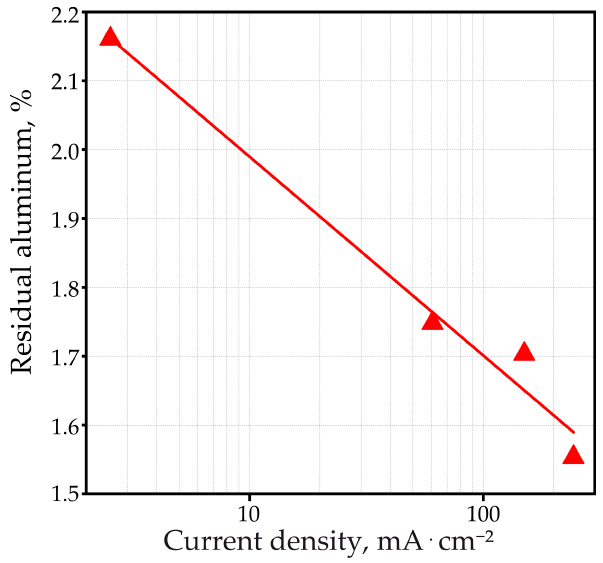
Figure 12. Quantification of residual aluminum content versus anodic current density based on areas under the 65.11° aluminum peak during galvanostatic anodizing in pure 0.6 M malonic acid.